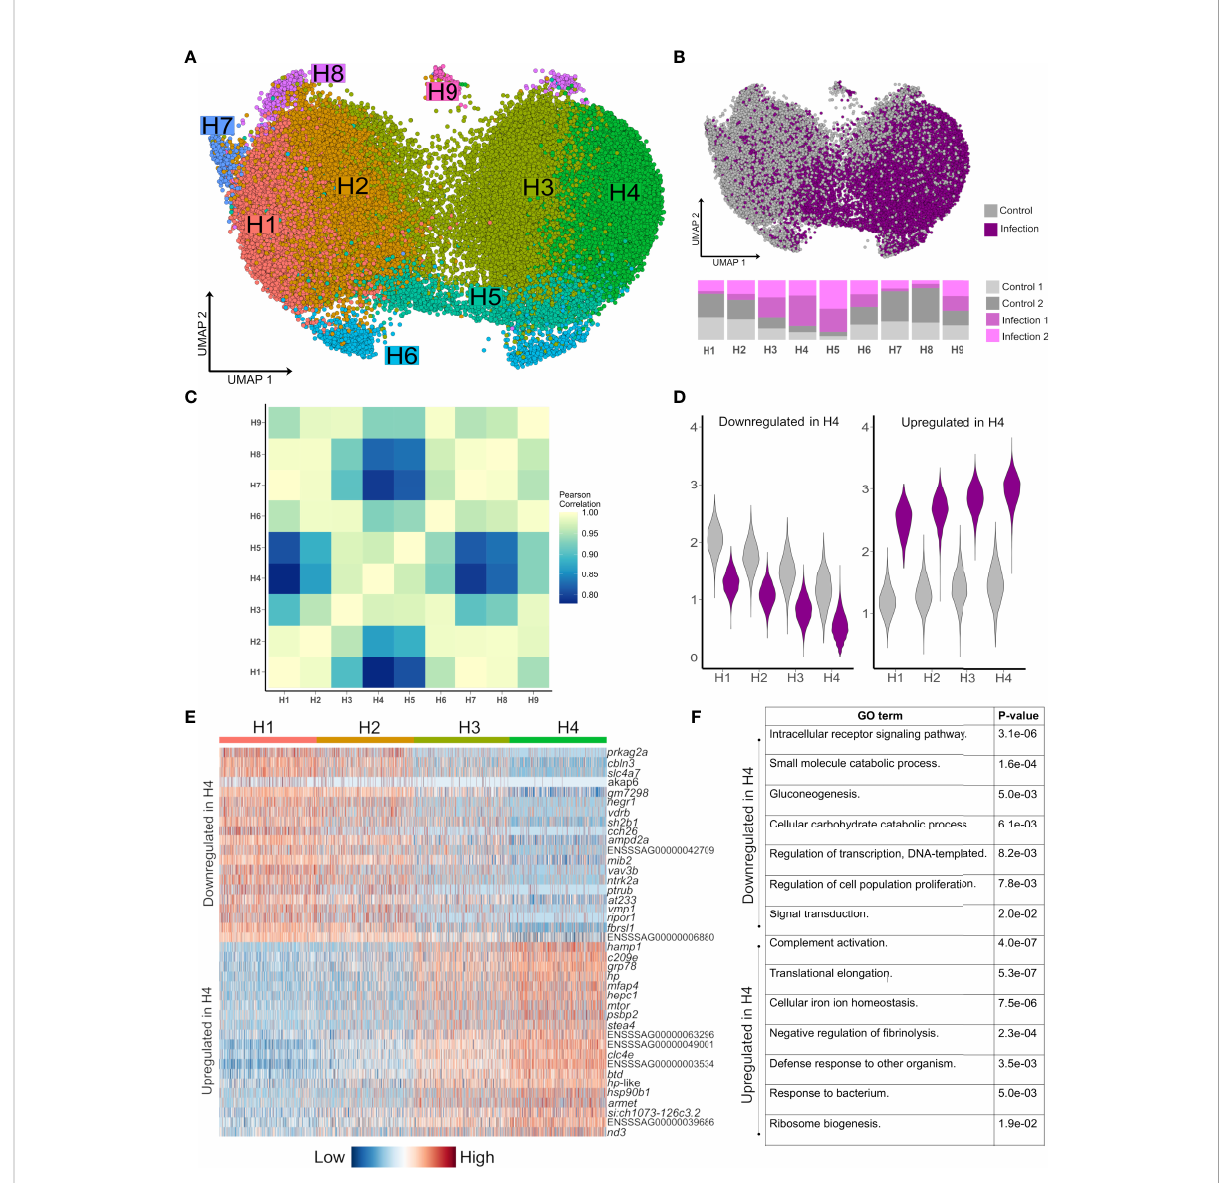
FIGURE 3 Striking remodeling of the hepatocyte transcriptome in response to bacterial infection. (A) UMAP visualisation of 41,792 hepatocyte nuclei, with sub-clustering performed using the most variable genes restricted to this cell lineage. (B) Shows the same UMAP with nuclei coloured by infection state (top) and the proportion of nuclei originating from each sample after normalising for different nuclei numbers across samples (bottom). (C) Pearson correlation of the expression values for the top 2,000 most variable genes across the nine hepatocytes populations H1- H9. (D) Violin plots of mean expression for the 20 most down-regulated (left) and up-regulated (right) genes based on log-fold change in H4 vs. H1. (E) Heatmap of the top 20 most upregulated and top 20 most downregulated genes in H4 relative to H1, illustrating a gradient of